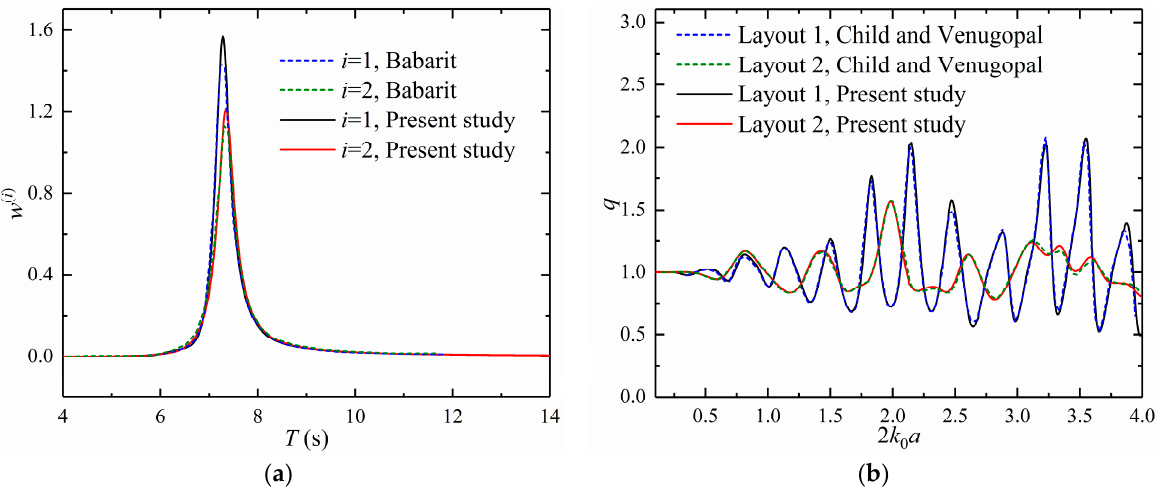
Figure 3. WEC array performance: ( a ) relative capture width of each WEC in an array composed of two heaving WECs; ( b ) interaction factor q of two optimized arrays composed of five heaving WECs.